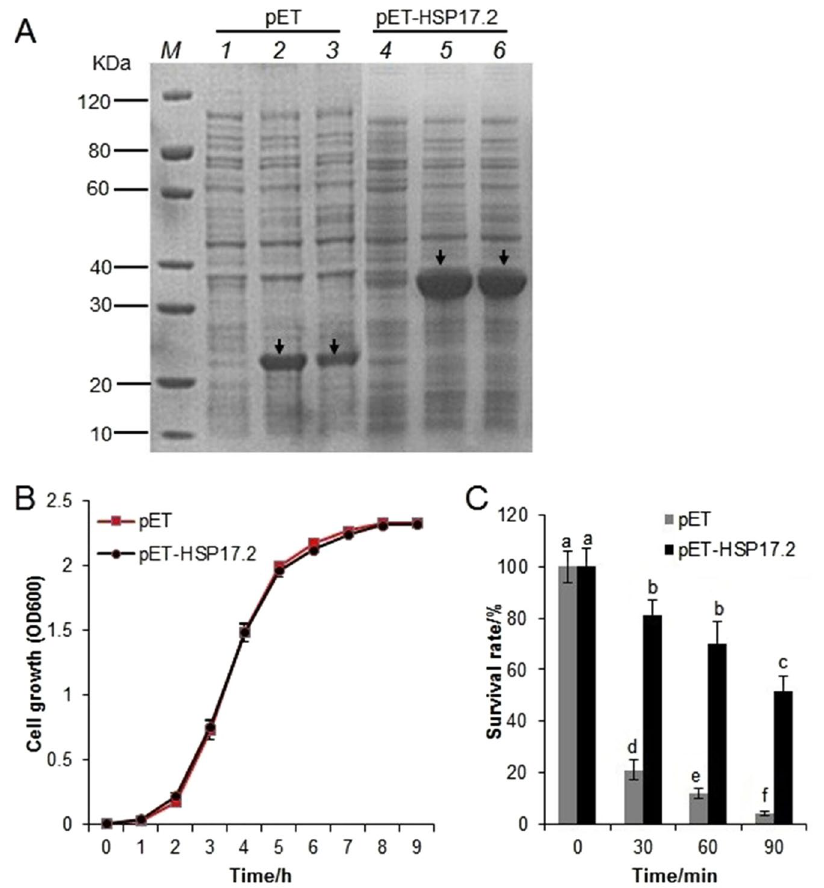
Figure 3. Heterologous expression of CsHSP17.2 in E. coli . ( A ) Expression of the CsHSP17.2 protein in E. coli assessed by SDS-PAGE analysis. M , protein molecular weight marker; lane 1: whole cell lysate of un-induced cells containing the empty vector pET; lane 2: whole cell lysate of cells cntaining the empty vector and induced by 0.2 mM IPTG at 15 °C for 16 h; lane 3: whole cell lysate of cells containing the empty vector and induced by 0.2 mM IPTG at 37 °C for 4 h; lane 4: whole cell lysate of un-induced cells containing pET-HSP17.2; lane 5: whole cell lysate of cells containing pET-HSP17.2 and induced by 0.2 mM IPTG at 15 °C for 16 h; lane 6: whole cell lysate of cells containing pET-HSP17.2 and induced by 0.2 mM IPTG at 37 °C for 4 h. The induced proteins are indicated by black arrows . ( B ) Growth analysis of transformed E. coli BL21 (DE3) cells under normal conditions. ( C ) Protective effect of recombinant CsHSP17.2 on cell viability during HS in vivo . The mean values of three independent experiments are plotted with error bars indicating standard deviations. The significant differences are indicated by different letters ( P <